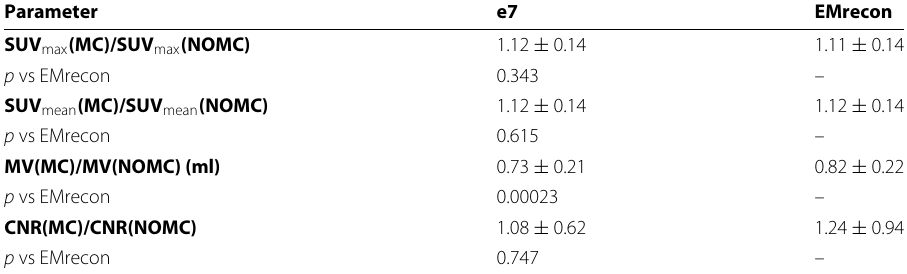
Table 4 Mean ± SD of MC/NOMC ratios for SUV max , SUV mean , MV, and CNR of all lesions Parameter e7